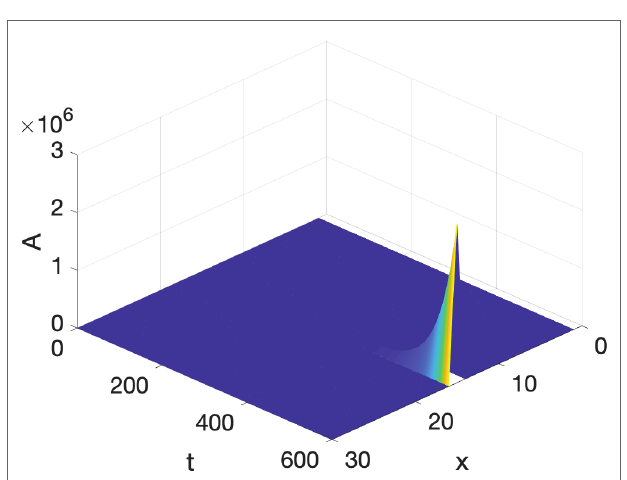
FIGURE 1 | Diffusion as loss of structure and gain of uniformity.